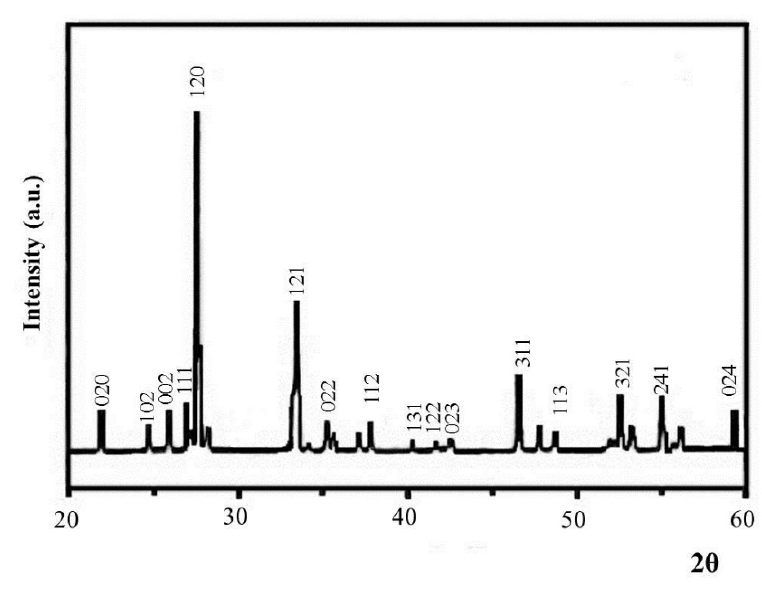
Symmetry code(s): (i) x −1, − y + 1/2, z + 1/2; (ii) x , − y + 1/2, z + 1/2; (iii) − x + 1, y + 1/2, − z + 1/2; (iv) − x + 1, y − 1/2, − z + 1/2; (v) − x + 1, − y , − z + 1. Bi 2 O 3 nanorods were produced via thermolysis of 1 at 170 °C with oleic acid as a surfactant. The powder XRD patterns (Figure 10) match the standard pattern of the Bi 2 O 3 tetragonal structure (JCPDS card file No. 76-1730), which confirms the formation of bismuth oxide. The average size of the particles was estimated by the Scherrer formula as 24 nm.